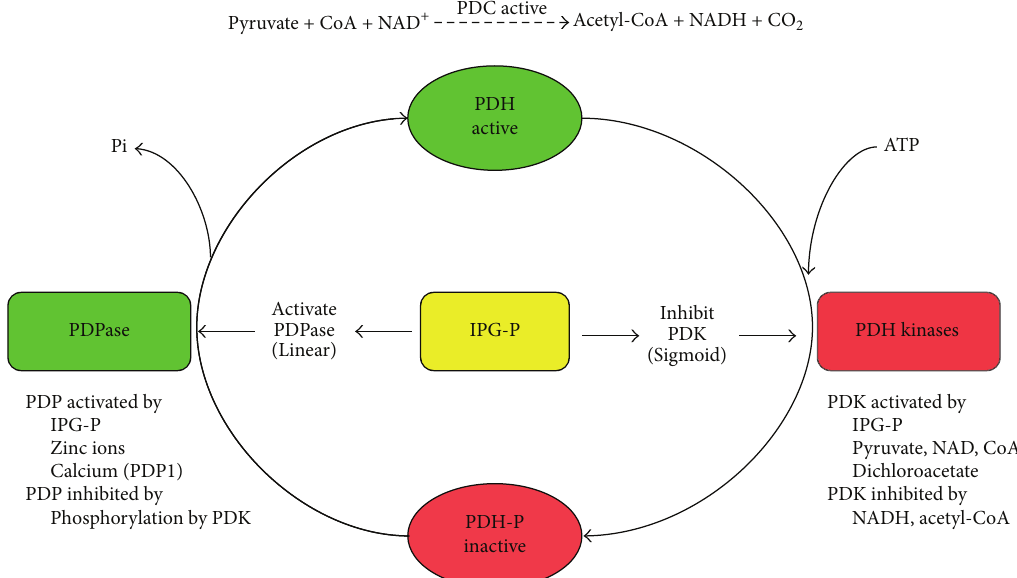
Figure 3: The reciprocal control of the pyruvate dehydrogenase complex has been shown in a previous article of ours [21] and is here represented in a scheme.